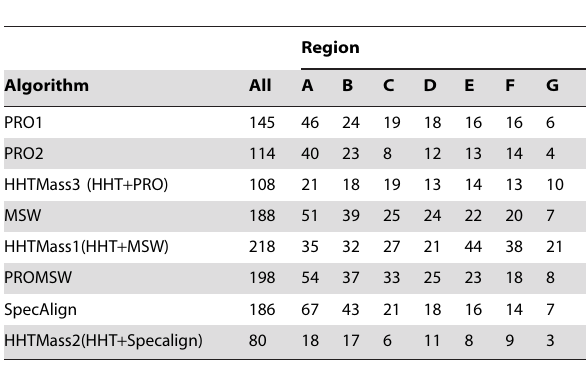
Table 2. The amount of the peaks detected in several popular